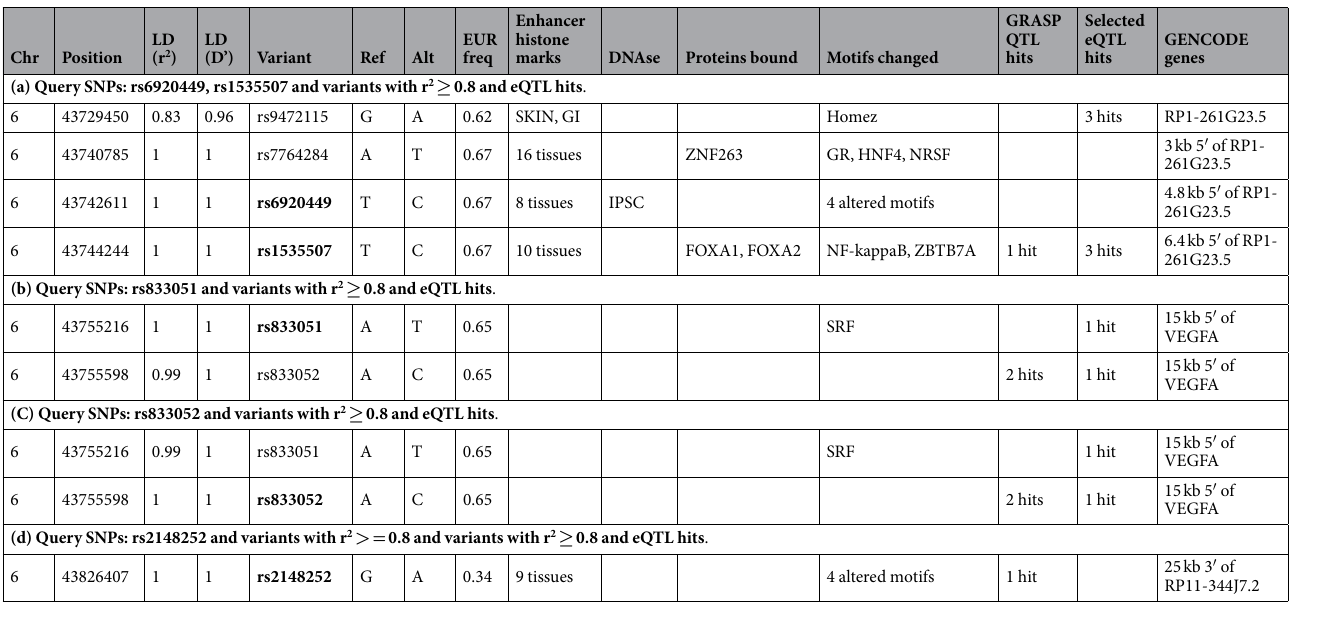
Table 5. Summary of eQTL